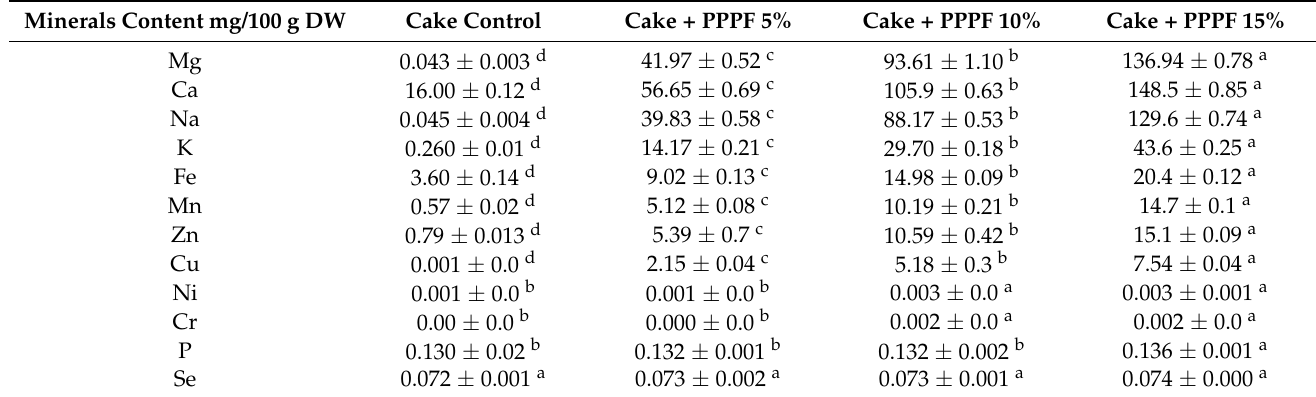
Table 6. Minerals content of cakes prepared by replacing flour with various levels of